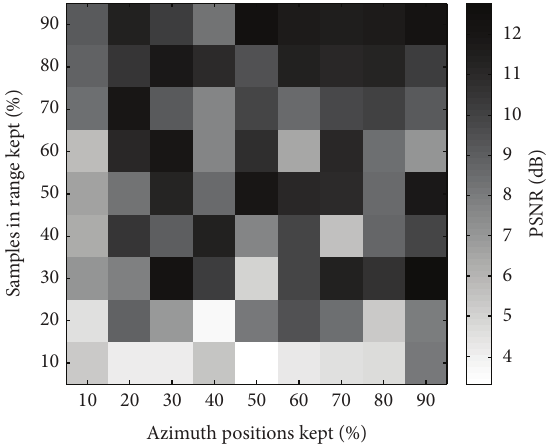
Figure 10: PSNR values in dB for different random downsampling possibilities in fast time and azimuth. A time-domain signal model was used to create the